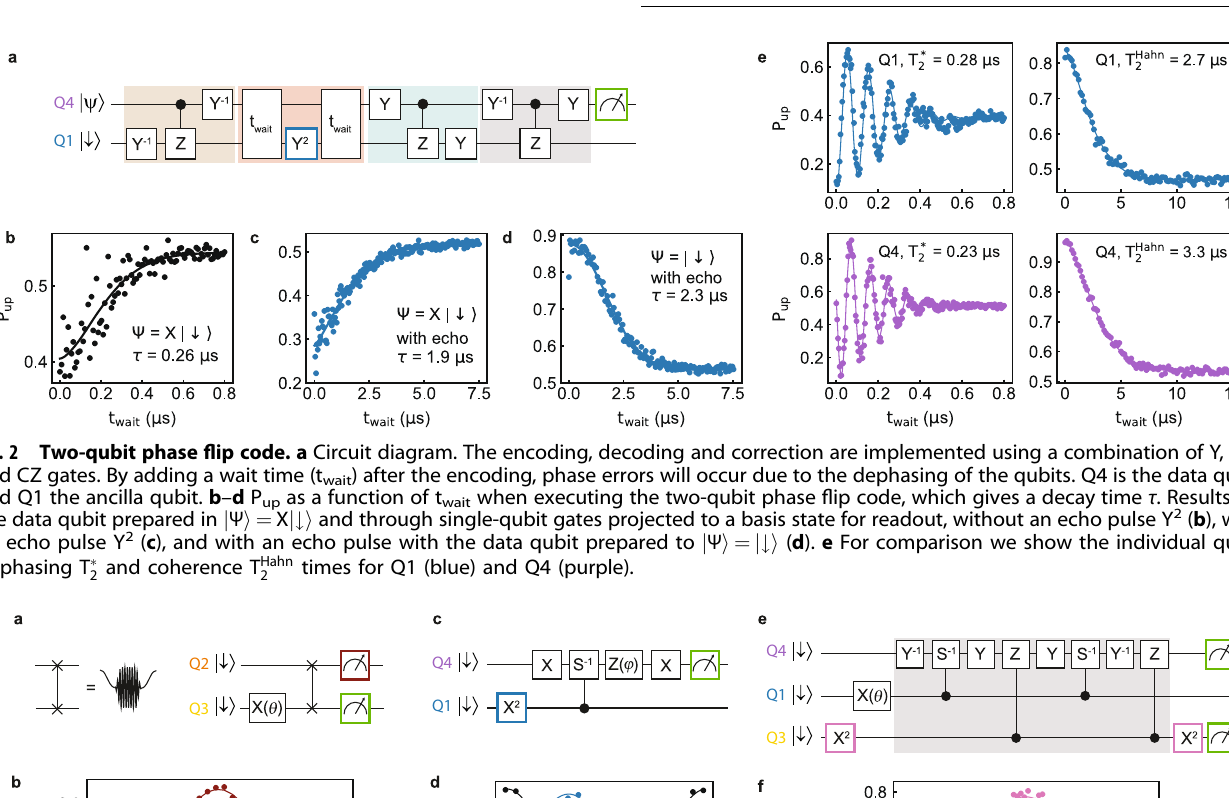
pulse, resonant with the difference in Zeeman energy of Q2 and Q3, superimposed on a Tukey-shaped pulse (see Supplementary Methods 3 for details on calibration). Figure 3a shows the circuit diagram to demonstrate resetting the state of Q3 using the SWAP. The result is shown in Fig. 3b, reading out either system Q1Q2 (red) or system Q3Q4 (green). This measurement shows that the states of Q2 and Q3 are swapped, but imperfections in the readout and initialization and in the calibration of the resonant exchange pulse result in a small residual amplitude on Q3. Figure 3c shows the circuit diagram to demonstrate the controlled-S − 1 (CS − 1 ) gate. The calibration of the CS − 1 gate is similar to the CZ gate (see Supplementary Methods 2), however, for the CS − 1 gate the exchange pulse is calibrated to give a phase difference of − π /2 between the experiments with and without a preparation pulse on the control qubit. This is demonstrated in Fig. 3d, where the results of a Ramsey experiment are shown with (blue) and without (black) an X 2 pulse on the control qubit Q1. The Toffoli gate is a three-qubit gate, also called Controlled- Controlled-NOT gate. In the three-qubit phase fl ip code, the